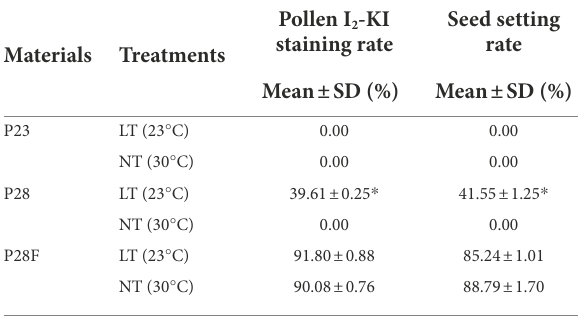
TABLE 1 Pollen fertility and seed-setting rate of P23, P28, and P28F.